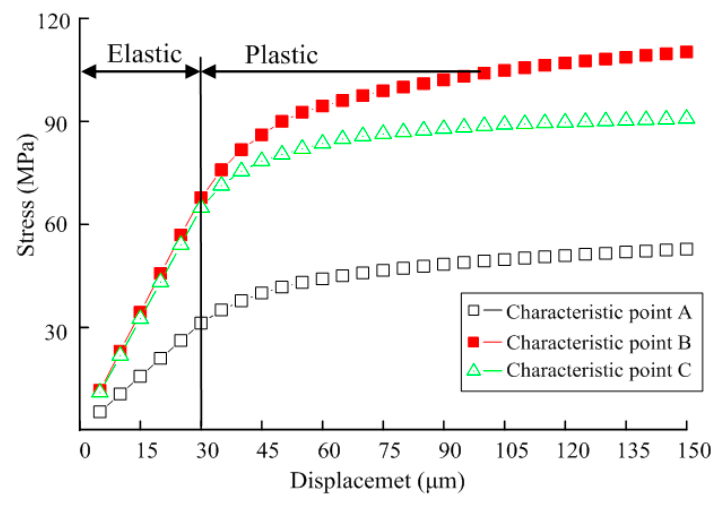
Figure 6. Finite element simulation model. 3.1. Biaxial Tensile Mechanical Performance Analysis During biaxial tension, the displacement-dependent stress variation curve at characteristic points A, B and C on the specimen were as shown in Figure 7. It is observed that the stresses on three characteristic points in the elastic stage show linear variation. In the case that displacement on both